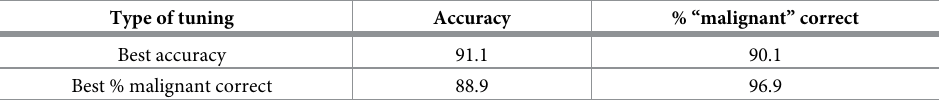
Table 5. Accuracy and percentage of “malignant” slides correctly classified differences based on type of tuning of hyper